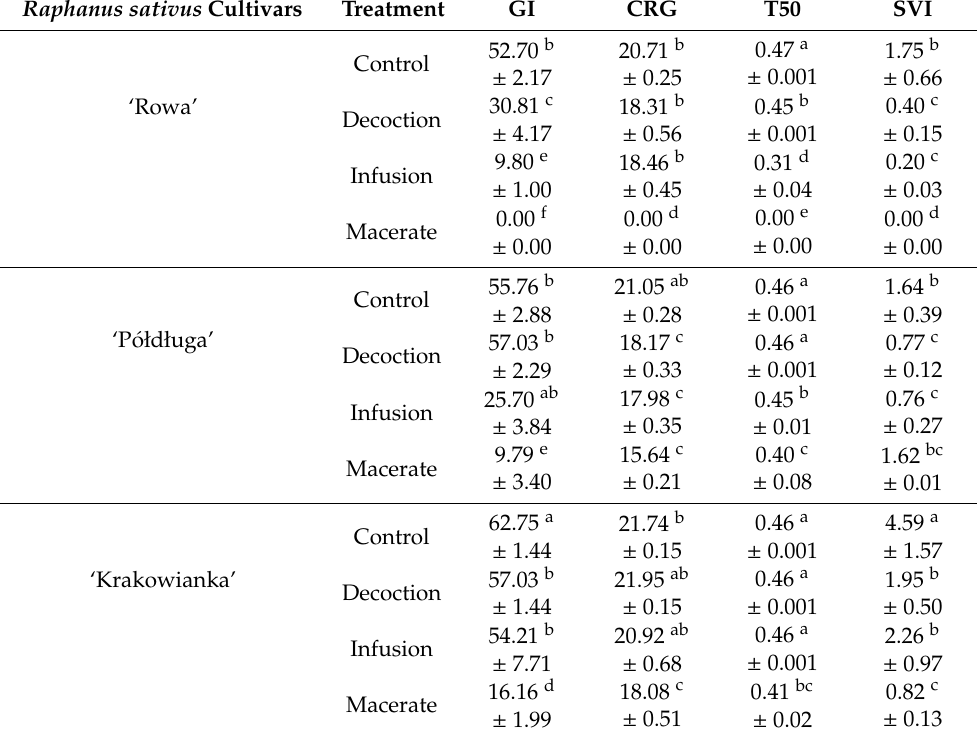
Table 2. Germination parameters of Raphanus sativus L. cv. Rowa, P ó łdługa, Krakowianka seeds germinated on the aqueous extracts from Solidago canadensis L. leaves and distilled water (control).